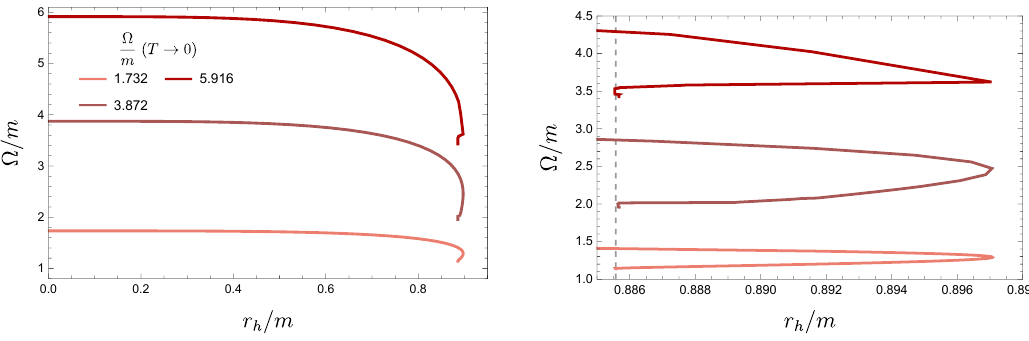
Figure 13 . Ω /m variation with r h /m . The right figure shows the endpoint of the curves. Both of them are bivaluated between r h /m = 0 . 8855 to r h = 0 . 8897 , and stop for r h /m = 0 . 8855